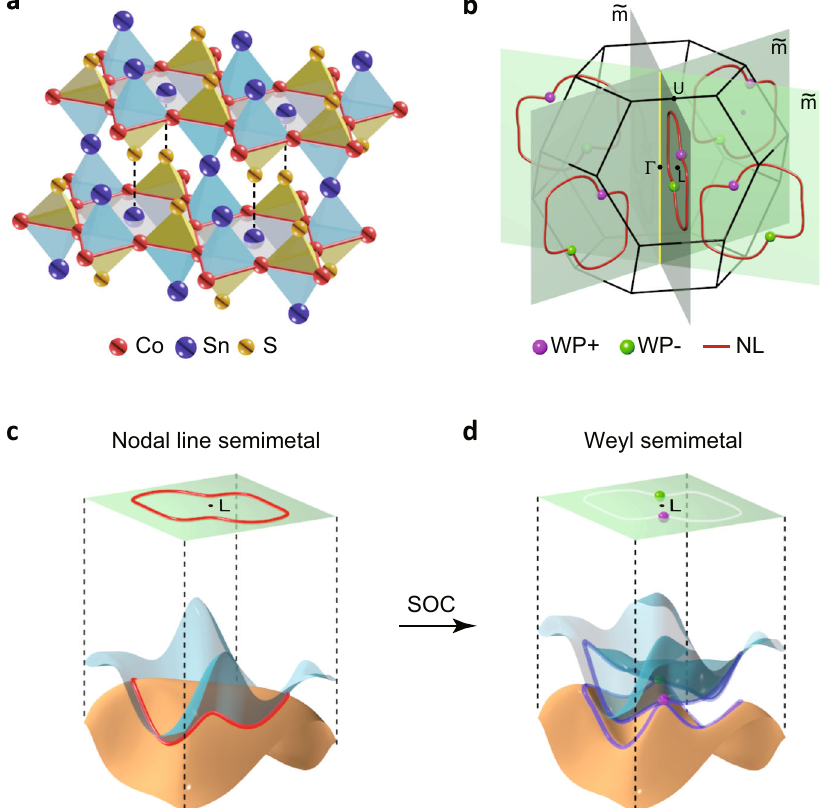
Fig. 1 Magnetic Weyl semimetal phase in Co 3 Sn 2 S 2 . a The crystal structure of Co 3 Sn 2 S 2 . b Schematic of the nodal line and Weyl points lying in three mirror planes of the bulk Brillouin zone. Red line represent the nodal line (NL) in the absence of the spin – orbit coupling (SOC) effect. In the presence of SOC, the nodal line will be partially gapped, leaving two nodal points forming the Weyl points (WPs) with positive ( + , the magenta color point) and negative ( − , the green color point) chirality, respectively. c Illustration of the nodal line originating from the band inversion in the absence of the SOC. d Illustration for the formation of the Weyl points and the partially gapped nodal line when SOC is